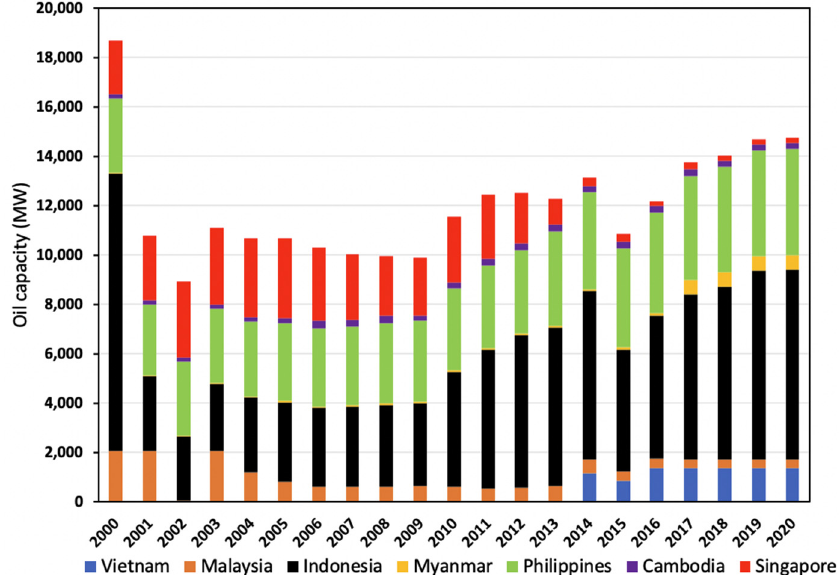
Figure 15. History of installed oil-power capacity in ASEAN [22] .